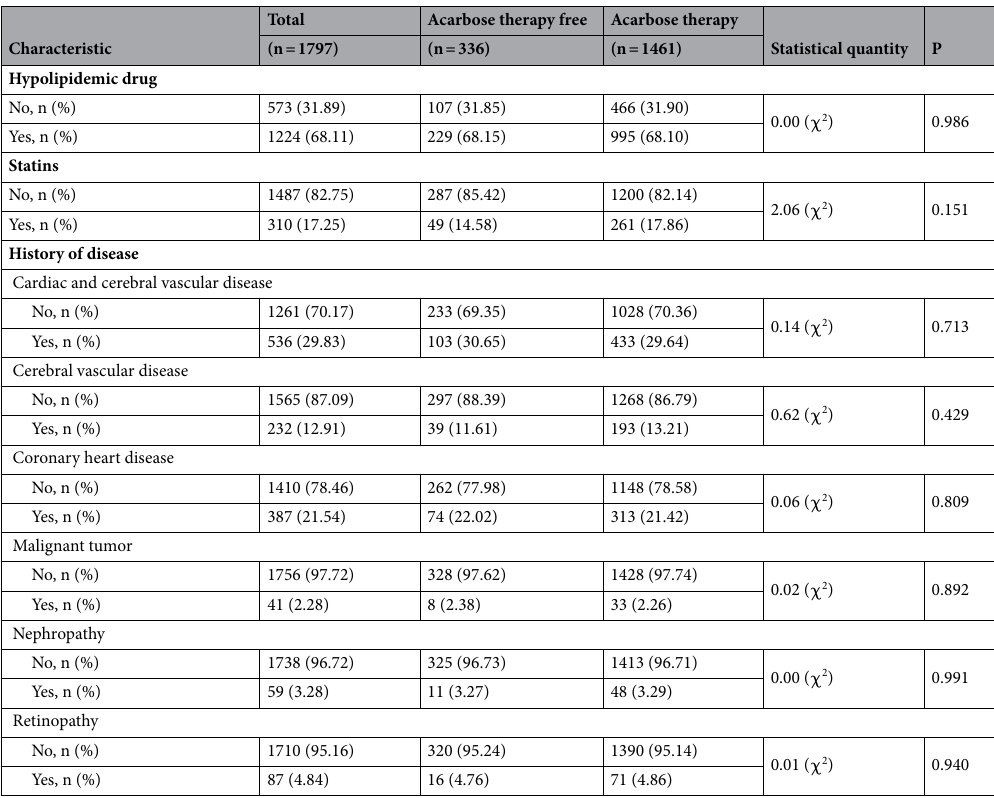
Table 1. Comparison of demographic and clinical characteristics between acarbose therapy free and acarbose therapy at baseline (2008) in the Beijing Communities Diabetes Study (Report 24). N = number of individuals. Values are expressed as mean ± SD, median (Q1, Q3) or number (%). P statistical significance of the differences between the two groups. BMI body mass index, SBP systolic blood pressure, DBP diastolic blood pressure,